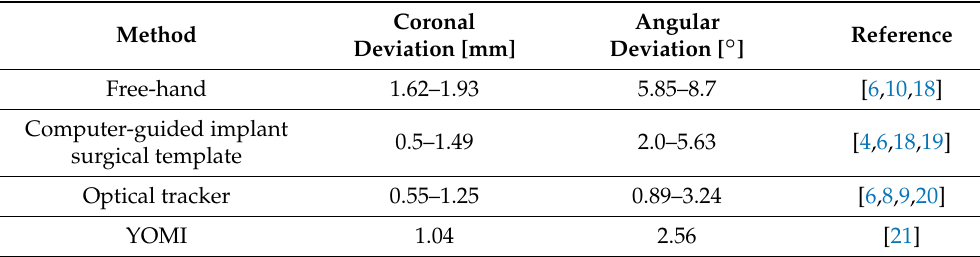
Table 1. Coronal and angular deviation of dental implant placement reported in the